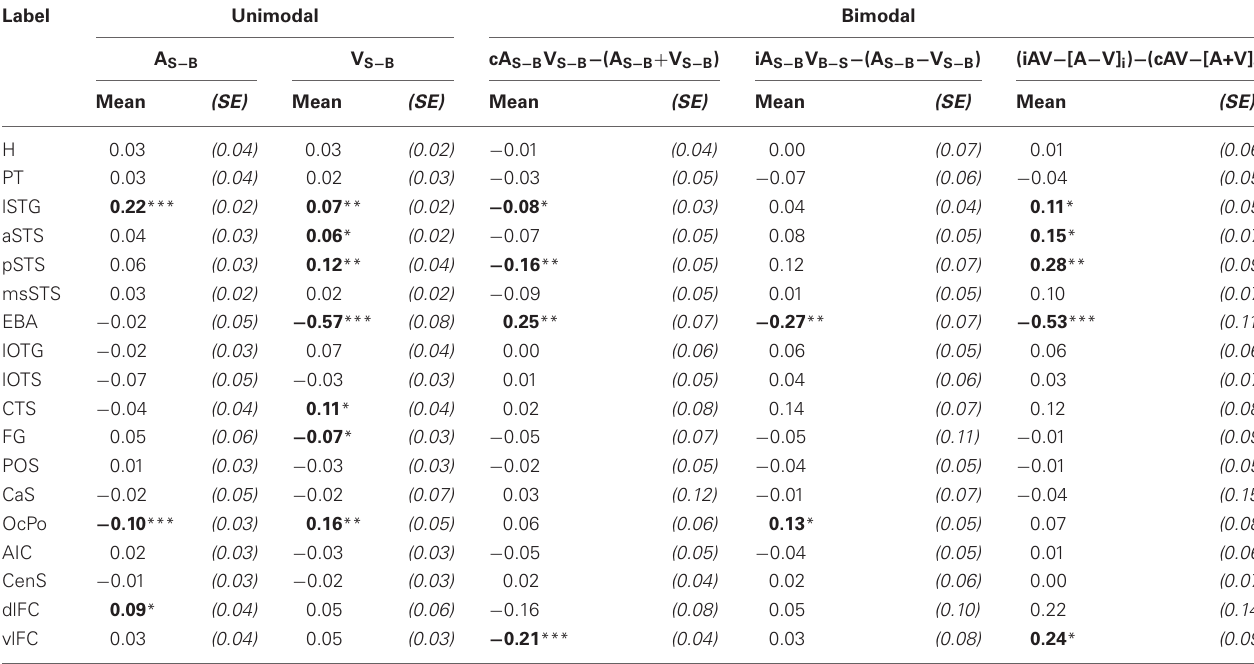
Table 2 | Difference (speech minus body) BOLD responses per ROI. Label